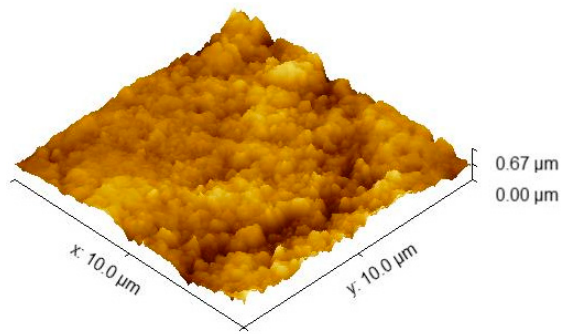
Figure 9. 10 × 10 µm 3D AFM image of the 3D-printed newly obtained composite with 0.4% nanoTiO 2. Also, a similar 3D topography was taken for a sample size of 5 × 5 µm.